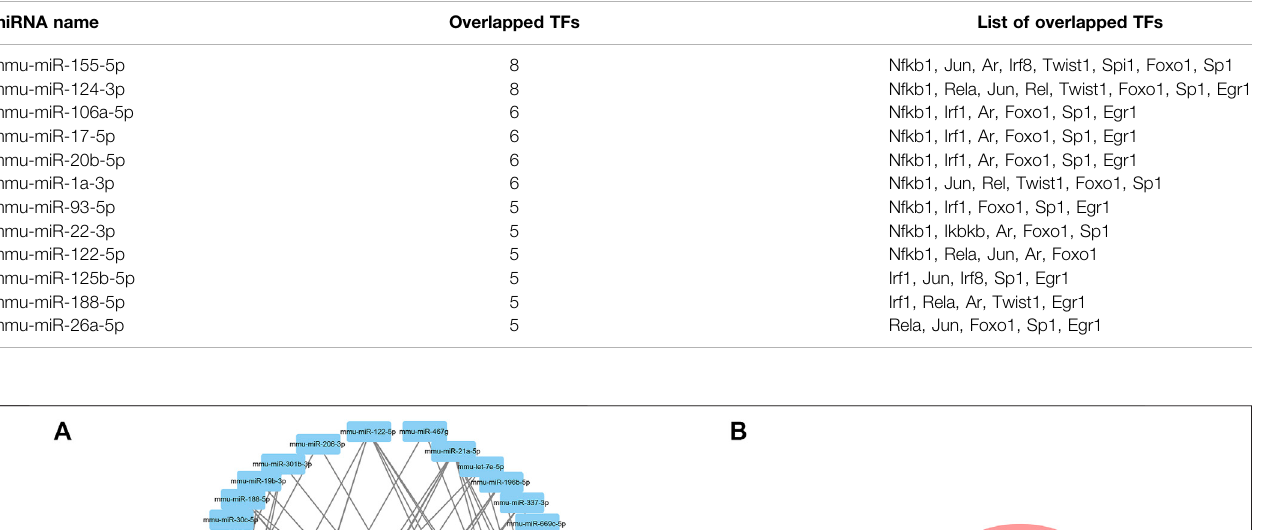
TABLE 3 | Prediction of the miRNAs of identi fi ed transcription factors via DIANA-TarBase.